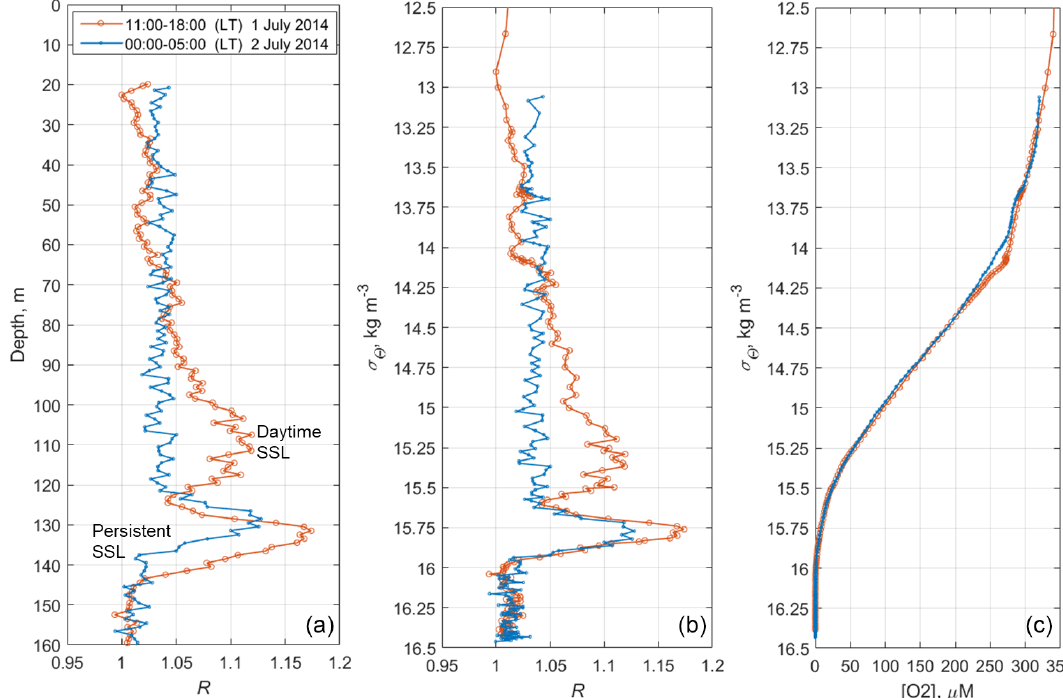
Figure 11. The time averages of R and [O 2 ] for the daytime of 1 July 2014 (red) and the nighttime of 2 July 2014 (blue), when net sampling (Fig. 10) took place. (a) The depth profiles of the time averages R . (b) The daytime and nighttime averages R vs. the specific density, σ (cid:50) . (c) Distribution of the daytime and nighttime averages of the dissolved oxygen concentration vs. σ (cid:50)